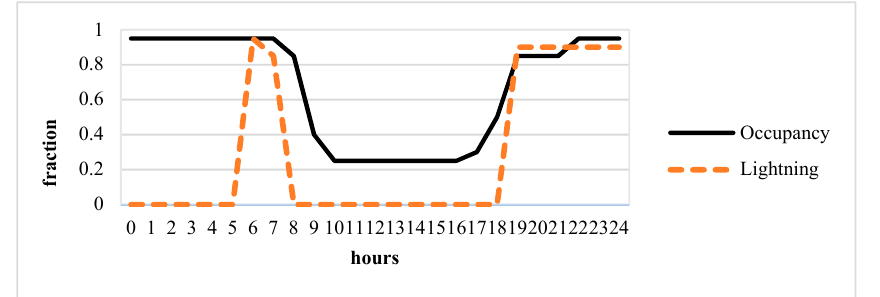
Figure 5. Occupancy chart of the building and the usage of lighting equipment for determination of internal gains.